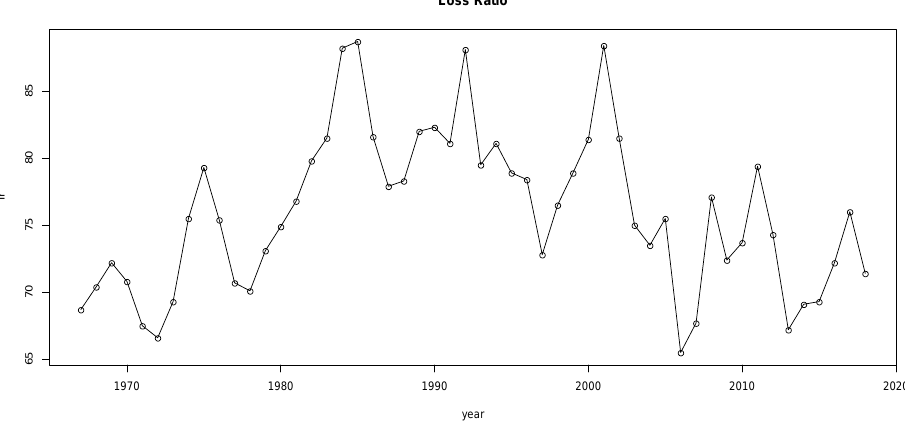
Figure 1. Loss ratios in the property and casualty insurance industry in the U.S. over 52 years, 1967–2018. (Source: Best’s Aggregates and